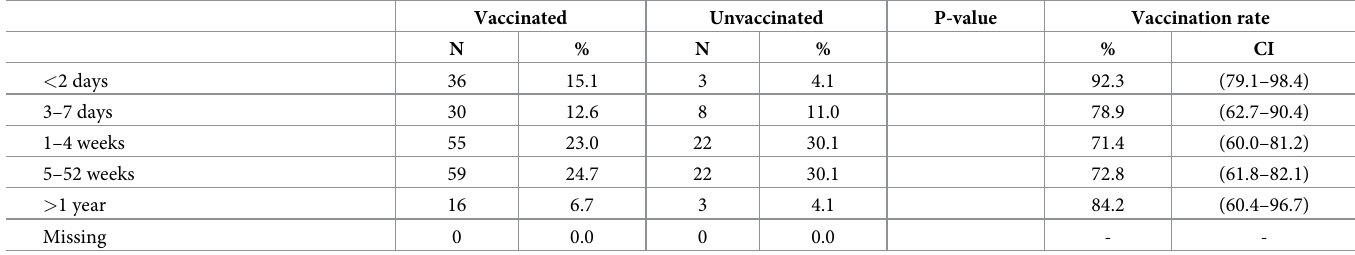
(Fig 2). No significant difference between vaccinated and unvaccinated girls was detected for the individual vaccine-targeted types. Vaginal samples had a prevalence of any HPV type of 39.1% and high-risk types 19.2% with comparable prevalence among vaccinated and unvacci- nated girls (38.5% vs 41.1%, PR: 0.93, 95% CI: 0.62–1.41) and (19.2% vs 19.2%, PR: 1.00, 95% CI: 0.55–1.83), respectively, (Table 2). The prevalence of the vaccine-targeted types (HPV6, 11, 16 or 18) was low overall, at 1.9% among all participants (6 positive samples). There was some evidence of lower prevalence among vaccinated (0.4%) than unvaccinated (6.8%) girls (PR: 0.06, 95% CI: 0.01–0.52), and this difference remained after adjusting for sexual behavior (PR: 0.04, 95% CI: 0.00–0.42). Only four oral samples were positive for any HPV type (1.3%), with a similar prevalence among vaccinated and unvaccinated girls (1.3% vs 1.4%, PR: 0.92, 95% CI: 0.10–8.81). Each of these four participants had received at least one dose of HPV vaccine at least 1 year before oral sexual debut, and each was positive for a single HPV type (HPV16, 67, 69, and 87). Two were positive for the same HPV type (HPV67 and 87) in their vaginal sample, while the other two were negative for the same HPV type in their corresponding vaginal sample. The analysis presented above for vaginal prevalence was also performed using an alternate cinated, sexual debut had to occur after vaccination. This increased the number of participants included to 314 (246 vaccinated and 68 unvaccinated), as the two participants who did not